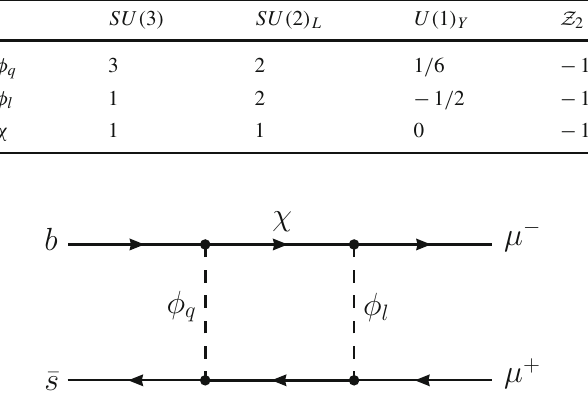
Table 1 Quantum numbers of the new fields. We also indicate the charges under Z 2